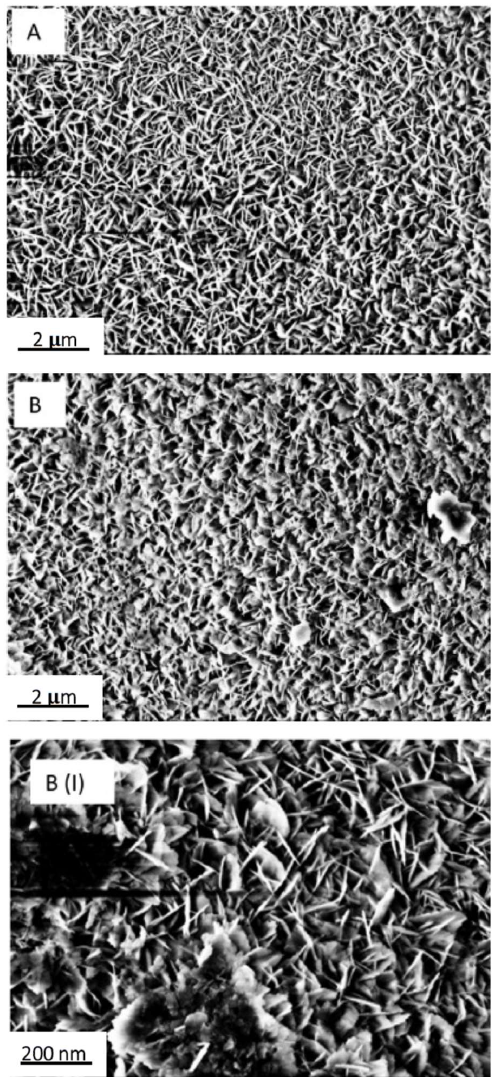
Figure 10. FE-SEM images of S sample ( A ) before and ( B ) after abrasion test. The greater magnification of B (labelled B(I) ) highlights the presence of some damage.